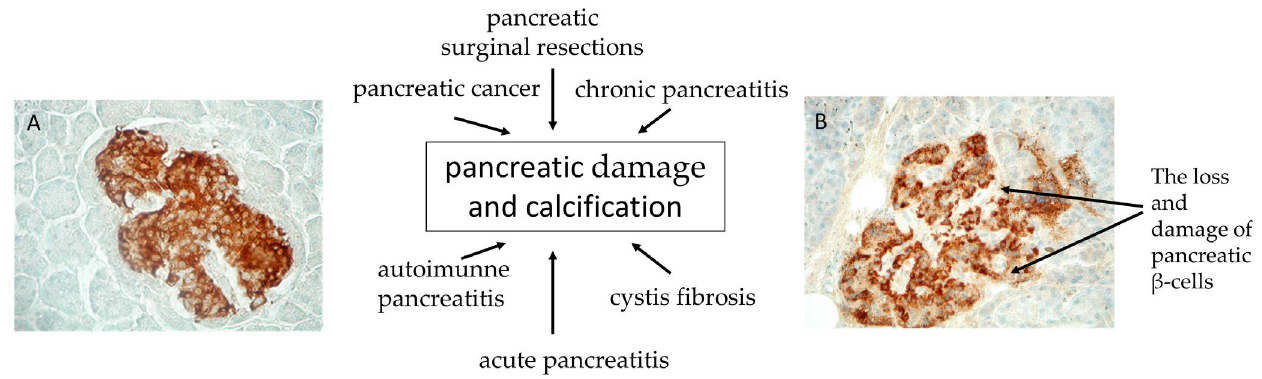
Figure 3. Immunohistochemical localization of insulin ( A ) in a normal pancreas and ( B ) in patients with diabetes type 3c. ( A ): (210 × ) Strong and very strong reaction of insulin in islet β -cells; ( B ): (265 × ) diffuse strong and moderate reaction of insulin in islet β -cells.